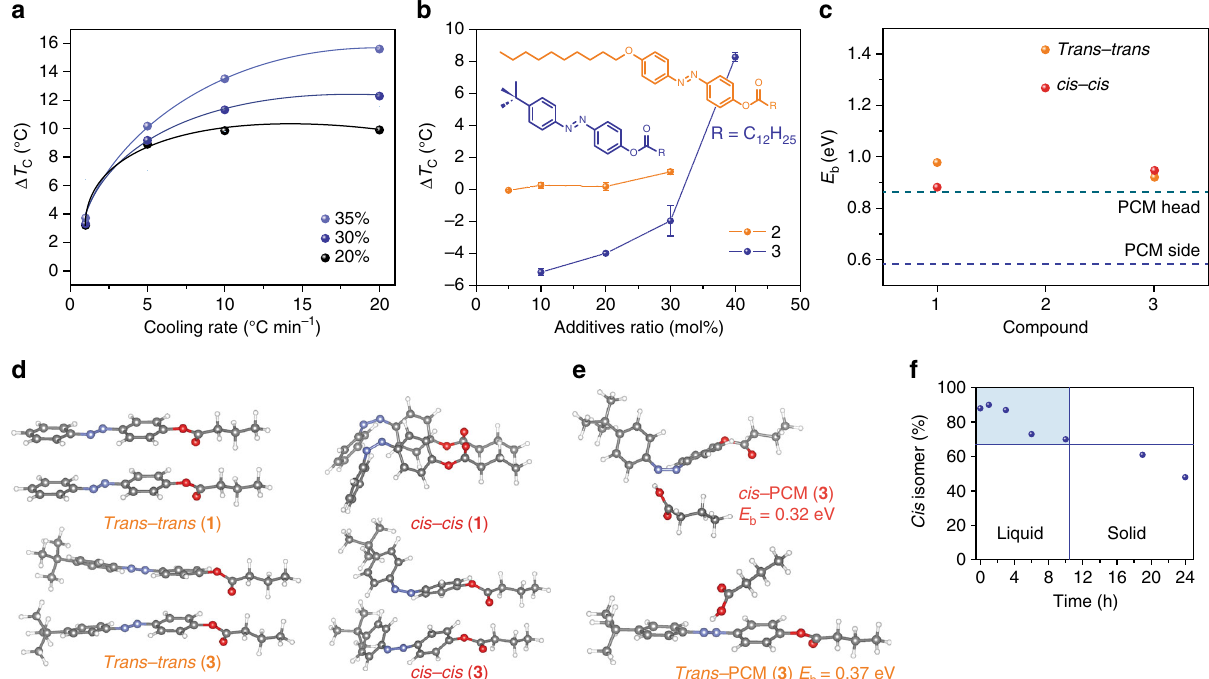
Fig. 4 In fl uence of measurement conditions and dopant structures on thermal storage properties. a Impact of cooling rate on Δ T c at varied doping levels. Δ T c generally increases with higher cooling rates, and was measured by DSC through heating and cooling between 10 °C and 70 °C. b Impact of functionalization of azobenzene dopants on Δ T c . Compound 2 is functionalized with a long alkyl chain (decyloxy group), and compound 3 is decorated with a bulky substitution ( tert -butyl group). Error bars indicate standard deviations of temperature measured at least 5 times on each type of composite. c DFT- calculated binding energy between two neighboring molecules (either as trans / cis isomer or PCM) varying with the functional group on the para -position of the azobenzene core. Dotted lines represent the head-to-head interaction between acid groups of the PCM (green) or the side-by-side interaction between alkyl chains of the PCM (blue). d DFT-simulated con fi gurations of two π – π stacking dopants (compound 1 and 3 ) as trans or cis isomer. e DFT-simulated con fi gurations of a dopant (compound 3 , cis or trans ) and a neighboring PCM molecule interacting around N = N group of azobenzene and – COOH group of PCM. f Stability of heat storage in a UV-charged liquid composite (30 mol% of compound 1 ) in the dark at 36 °C. The thermal reverse conversion of azobenzene dopants ( cis → trans ) was monitored by 1 H NMR (half-life of 24 h). For 10 h (with more than 65% cis fraction), the composite remains a liquid, conserving heat (shaded area). After 10 h, PCM molecules gradually solidify, and the composite loses the stored heat over time under